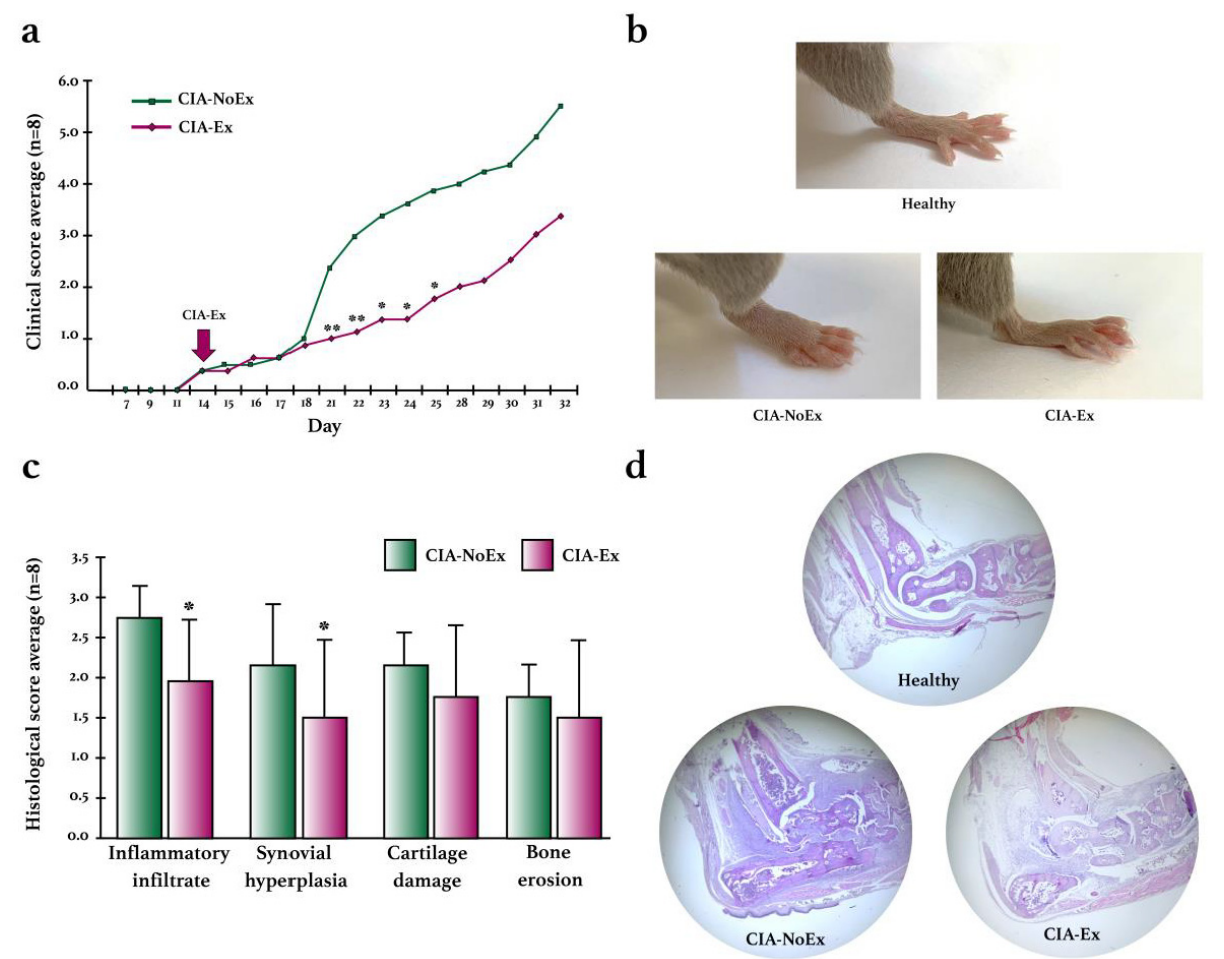
Figure 4. Clinical and histological effects of treadmill physical exercise in the preclinical collagen- induced arthritis in DBA/1 mice. ( a ) Evaluation of the clinical course of arthritis. Erythema and swelling were evaluated using the semiquantitative scale from 0 to 4 in each paw and the sum of the four paws per mouse was obtained. The mean score and standard deviation were calculated and graphed for each group during the experimental intervention. ( b ) Representative images of the clinical manifestation of CIA in control and exercised mice. ( c ) Histological evaluation in the hind paws by H&E staining. Inflammatory infiltrates, synovial hyperplasia, cartilage damage, and bone erosions were evaluated using the semiquantitative scale from 0 to 4. The mean score and standard deviation were calculated and graphed for each group. ( d ) Representative images of the histological findings in the hind paws using H&E staining. The Mann–Whitney U test was used to determine statistically significant differences when p < 0.05. * p ≤ 0.05; ** p ≤ 0.01.